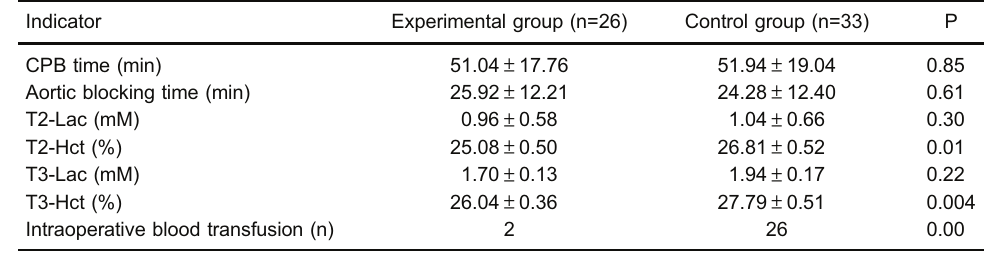
Table 2. Intraoperative indicators between two groups. Indicator